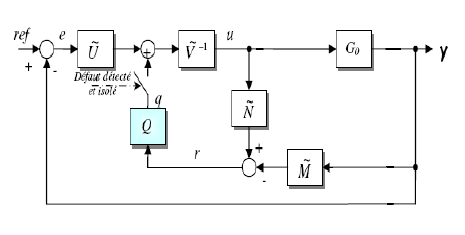
Fig.4. GIMC structure with commutation logic.